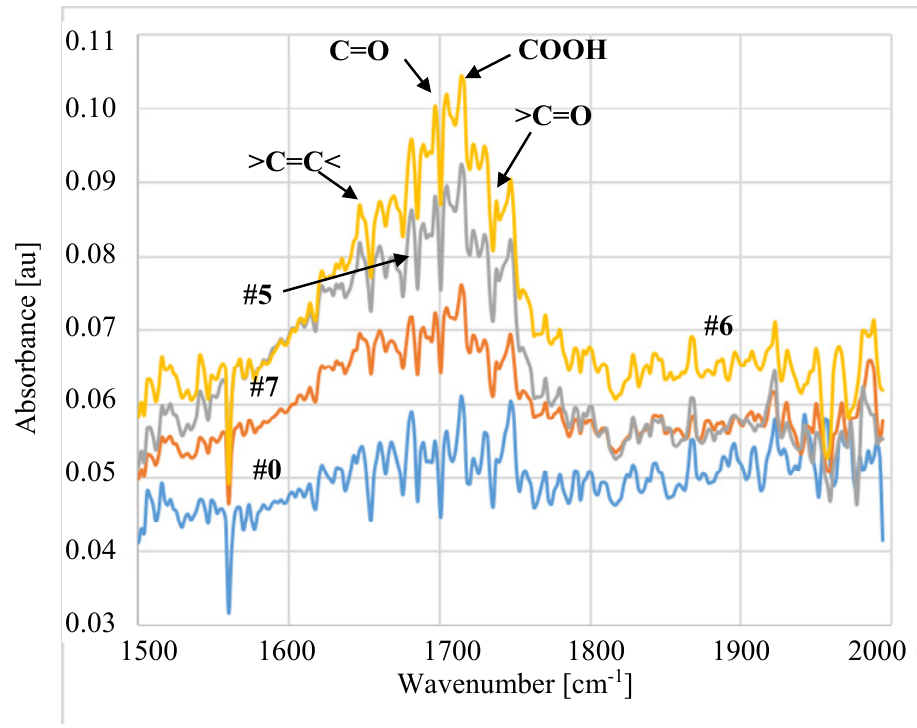
Figure 18. Results of ATR-FTIR analyses. Membrane treated by Ar/O 2 plasma. The FTIR tests showed that, regardless of the gas plasma composition (pure Ar or Ar/O 2 ), the formation of similar types of hydrophilic groups was detected on the membrane surface (Figures 17 and 18). This observation confirms the results obtained in other studies [37,39] showing that during the contact of membranes with air, free radicals